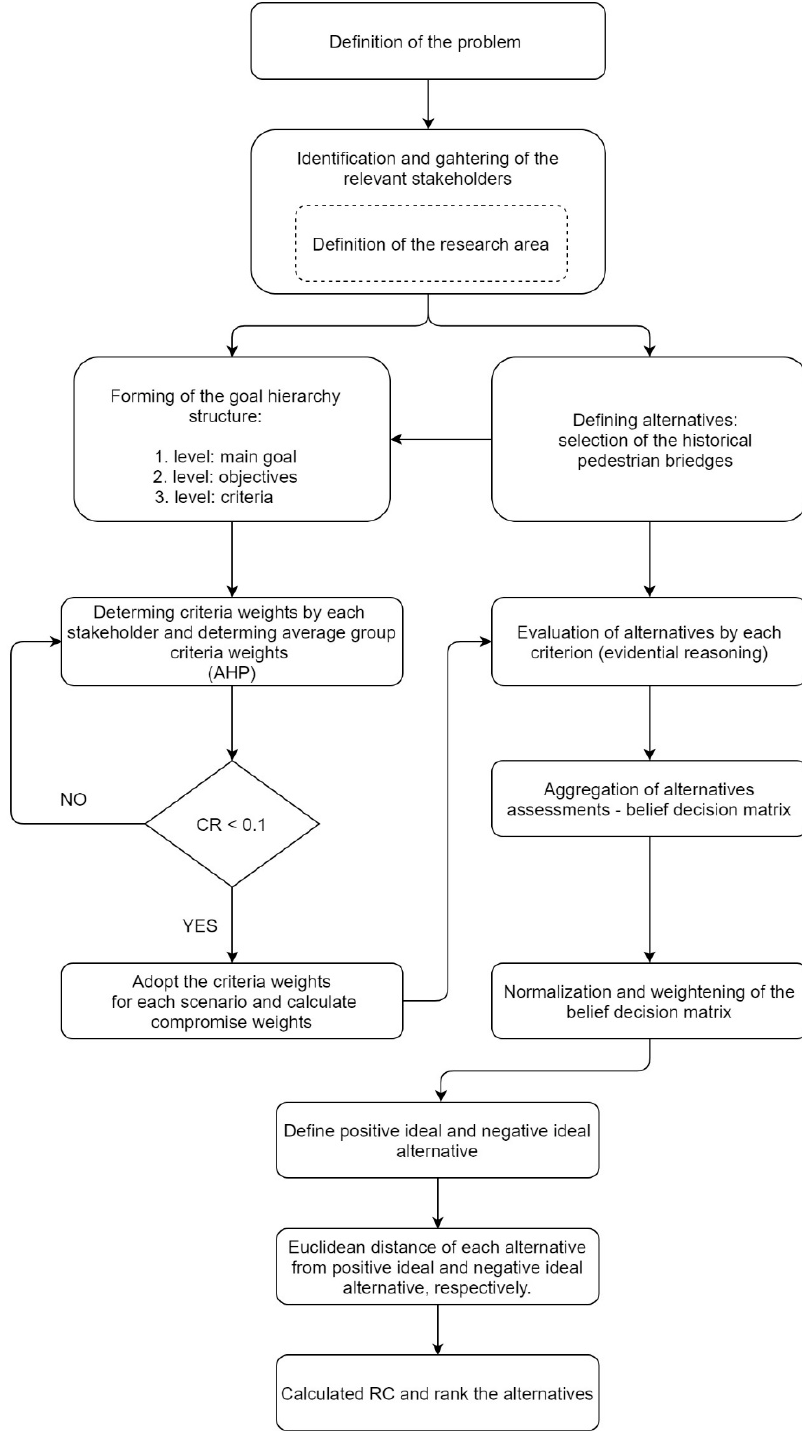
Figure 1. The decision concept to the recovery planning of historic pedestrian bridges.